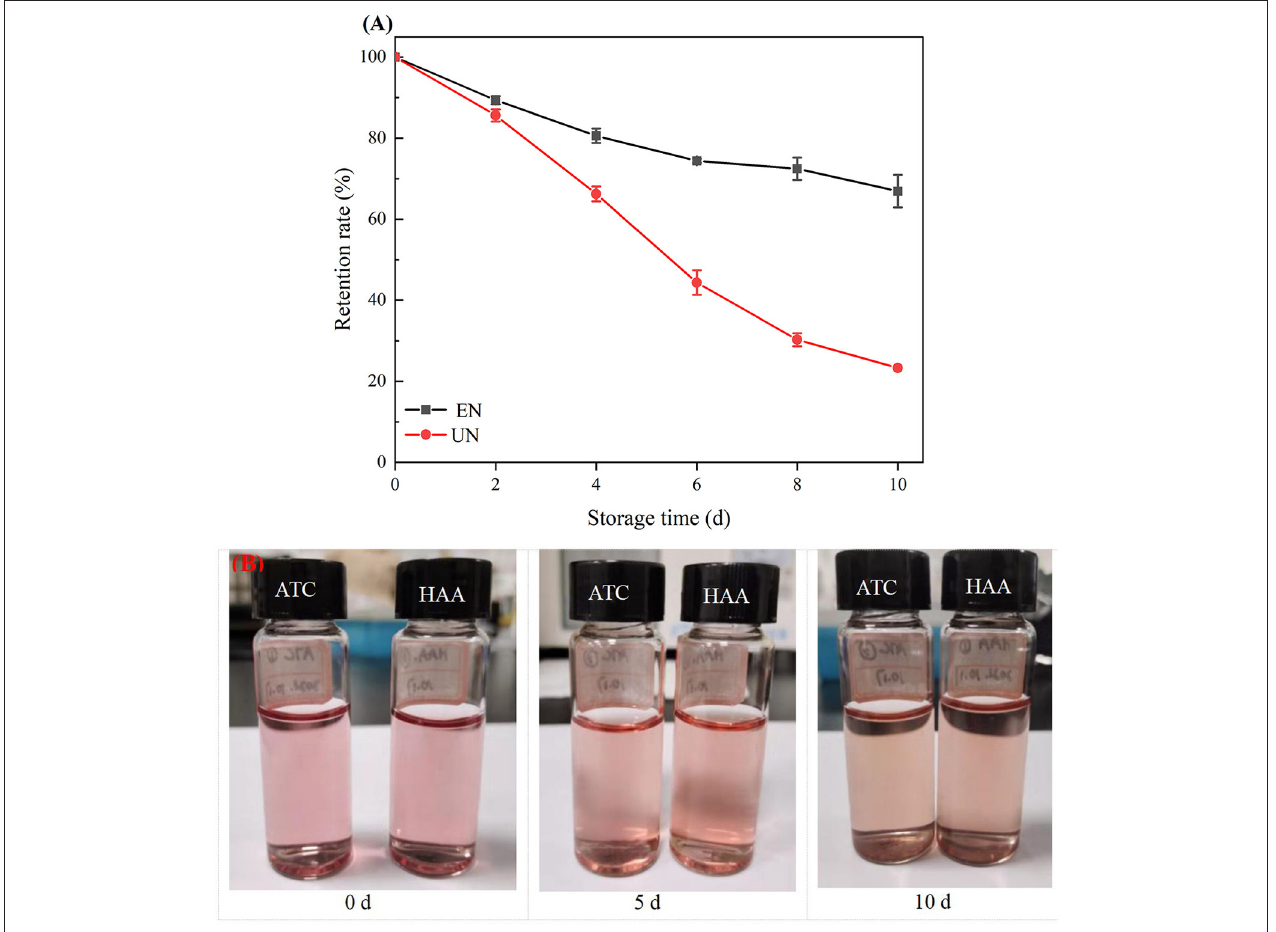
FIGURE 6 | (A) The stability of black rice ATC under 10 days of light; (B) Photographs of free ATC and HAA under 10 days of